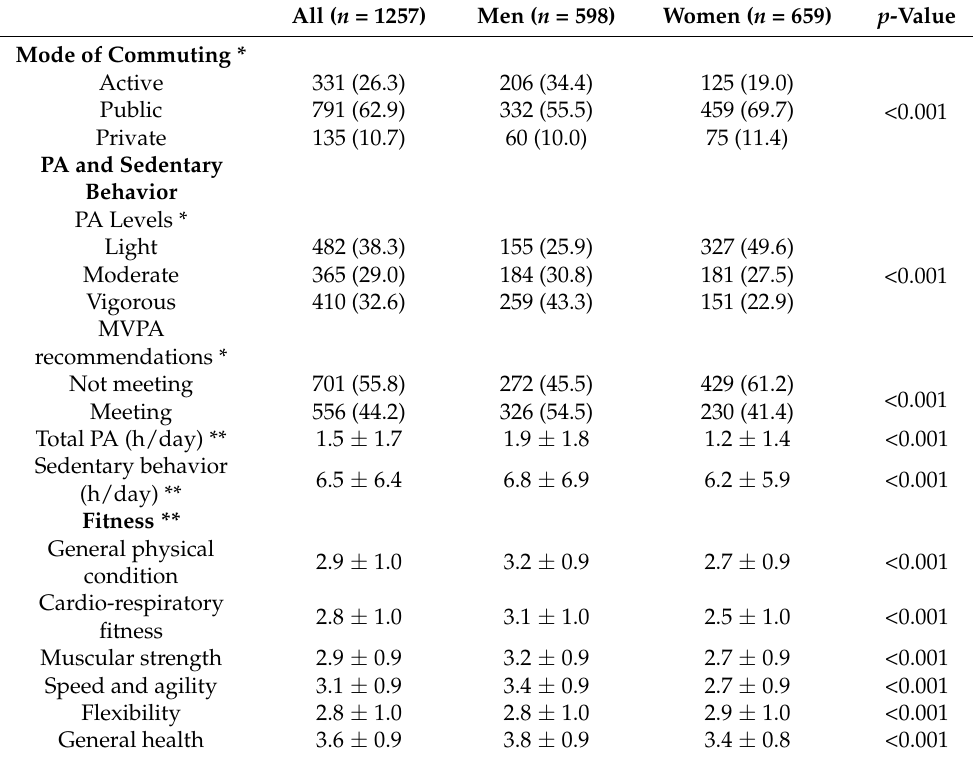
Table 1. Descriptive data of the mode of commuting, PA and sedentary behavior and fitness of the participants, and significant differences in the